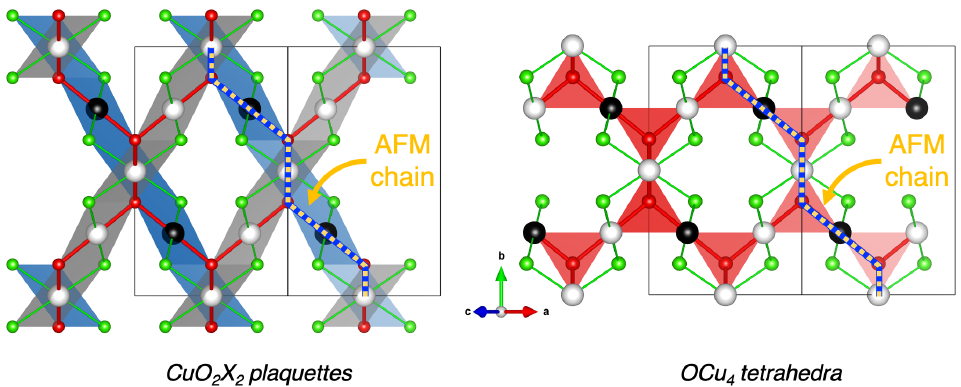
Figure 5. Schematic representation of the ground-state AFM collinear magnetic structure within the ( left ) ribbons- and ( right ) pyrochlore-like lattices. Black and white spheres indicate up and down spins carried by Cu sites, respectively. Red and green spheres represent oxygen and halogen species, respectively. The OCu 4 tetrahedral coordinations are represented in transparent red. The CuO 2 X 2 plaquettes are shown in transparent blue and gray for an up or down spin carried by the central Cu, respectively. One AFM spin chain, formed by the J = J 3 coupling and considered within the quasi-1D AFM model, is evidenced by a yellow–blue dotted